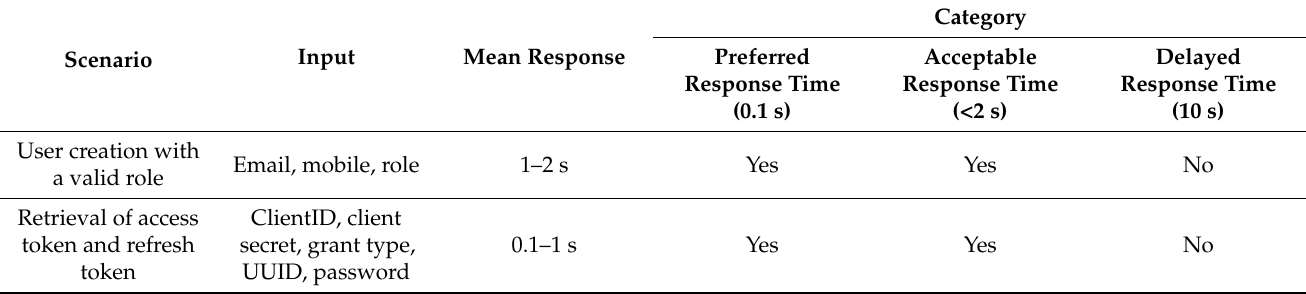
Table 8. Performance of unit-testing with Mockito